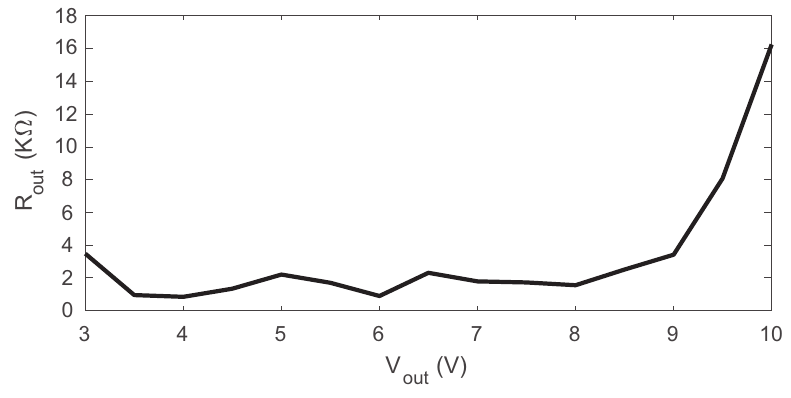
Figure 12. Measured output